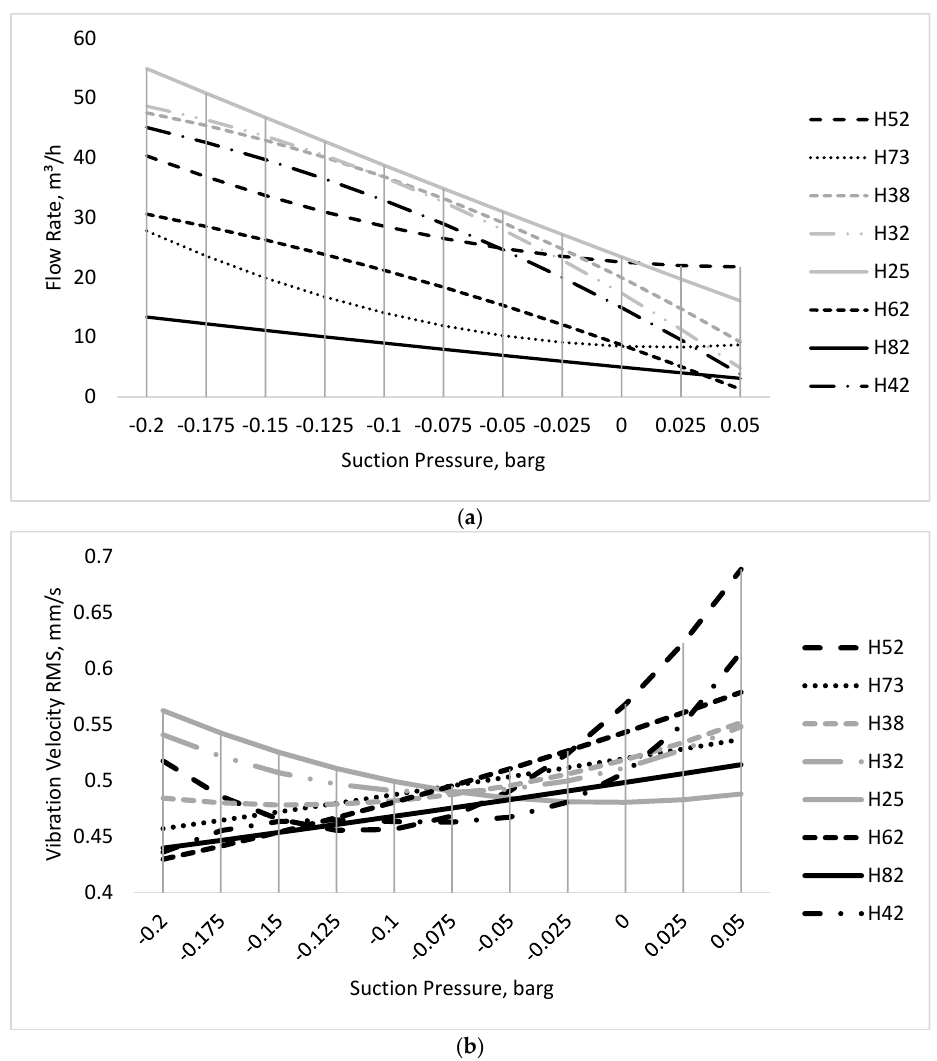
Figure 9. The influence of the suction pressure: ( a ) concerning the pump flow; ( b ) concerning the vibration velocity.